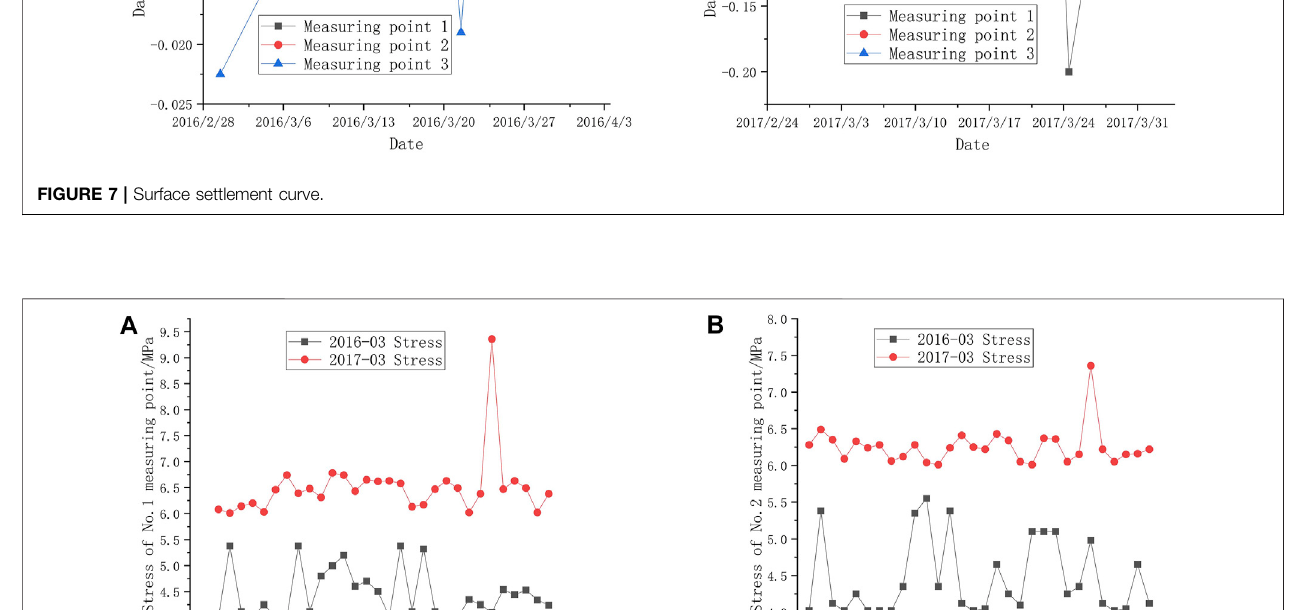
Frontiers in Earth Science |